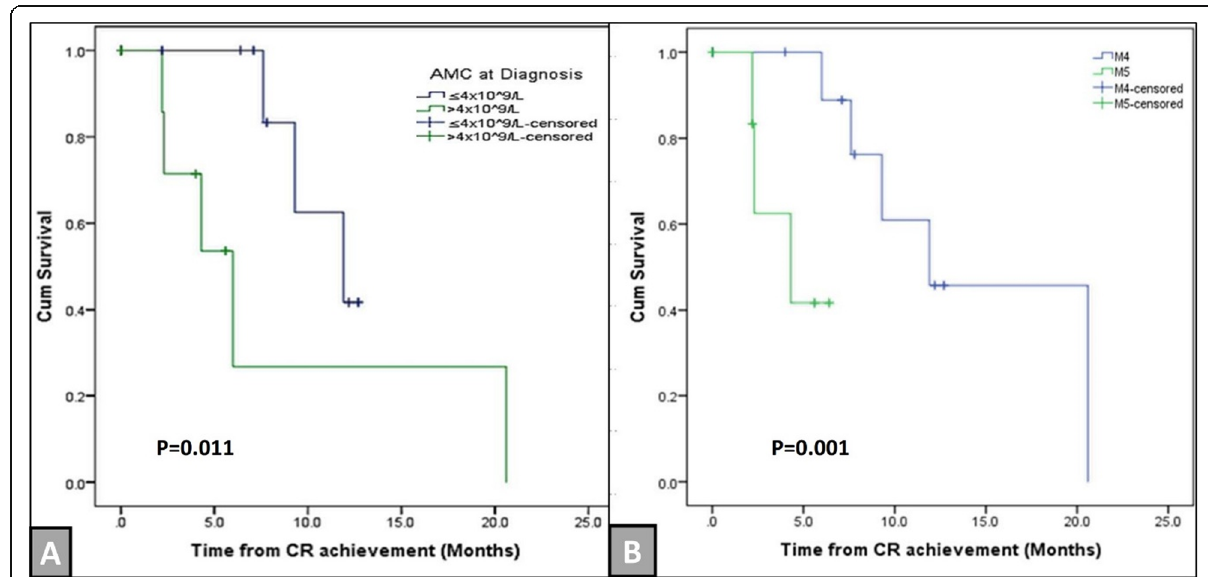
Fig. 6 The 3-year disease-free survival analysis in different subgroups. a The 3-year disease-free survival as regard the initial AMC (absolute monocyte count) level. b The 3-year disease-free survival as regard the AML-subgroups